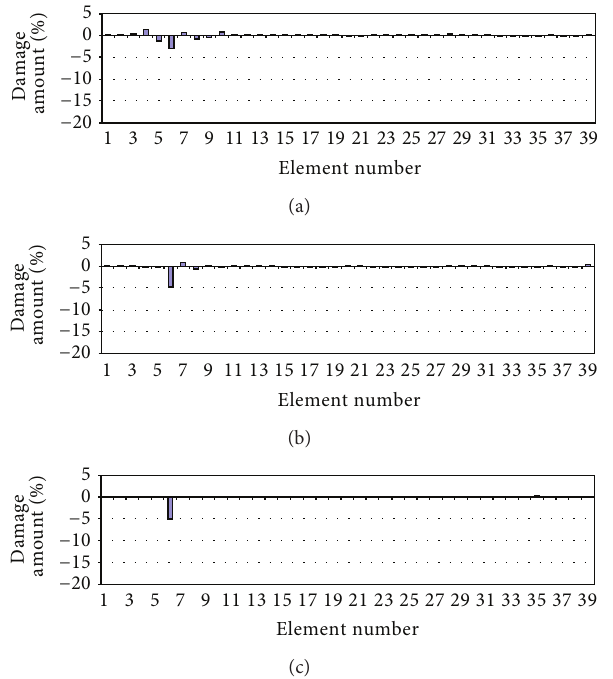
Figure 2: Inverse damage predictions for scenario 1 affected by the number of damaged-structure frequencies (NF), 60 original eigenvectors (NM) used, (a) 13 damaged-structure frequencies used, (b) 20 damaged-structure frequencies used, and (c) 35 damaged- structure frequencies used.